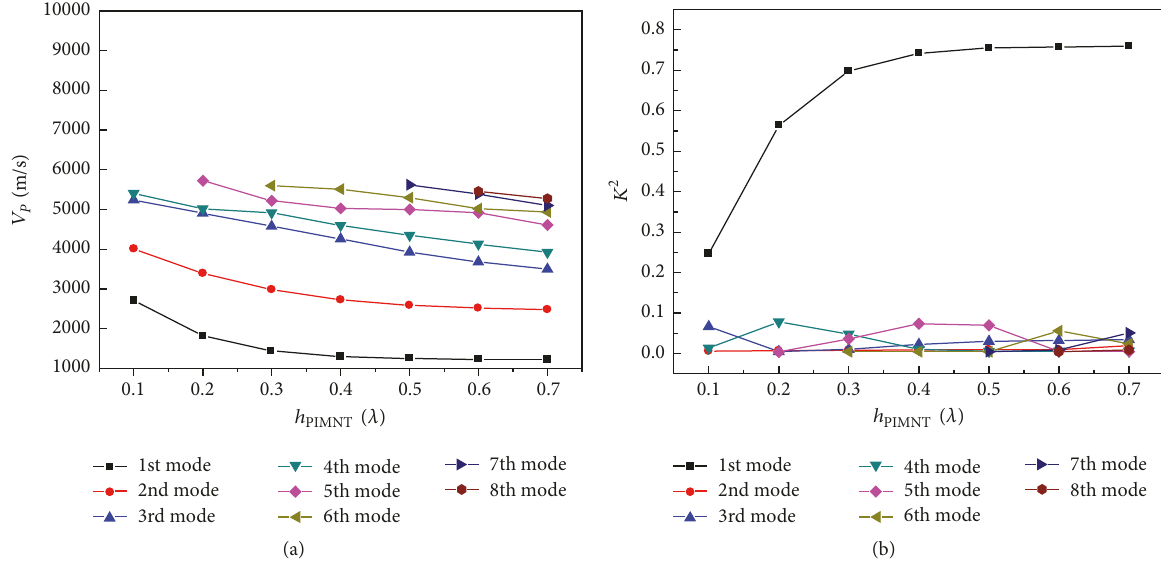
Figure 5: Dispersion curves of phase velocity (a) and 𝐾 2 (b) as a function of ℎ PIMNT